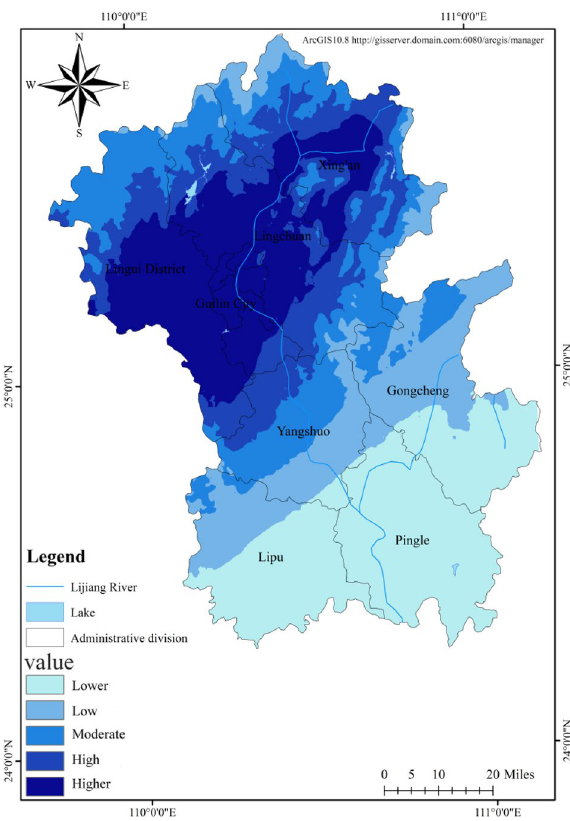
Figure 4. Spatial distribution pattern of hazard factors of flood disaster in Lijiang River Basin.